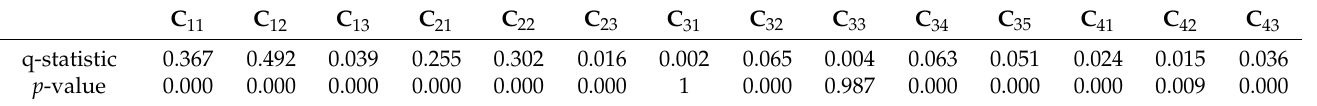
Table 8. The q-statistics on factors influencing land suitability.